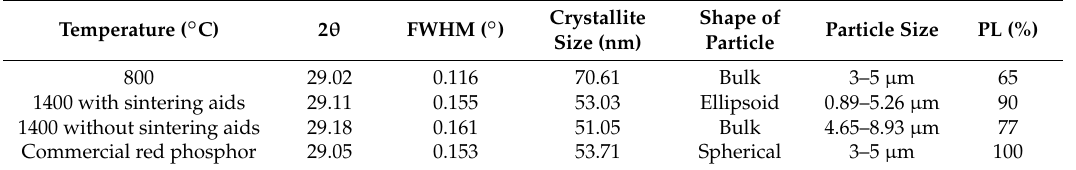
Table 7. Physical Characteristics and PL Efficiency of Y 2 O 3 :Eu particles.